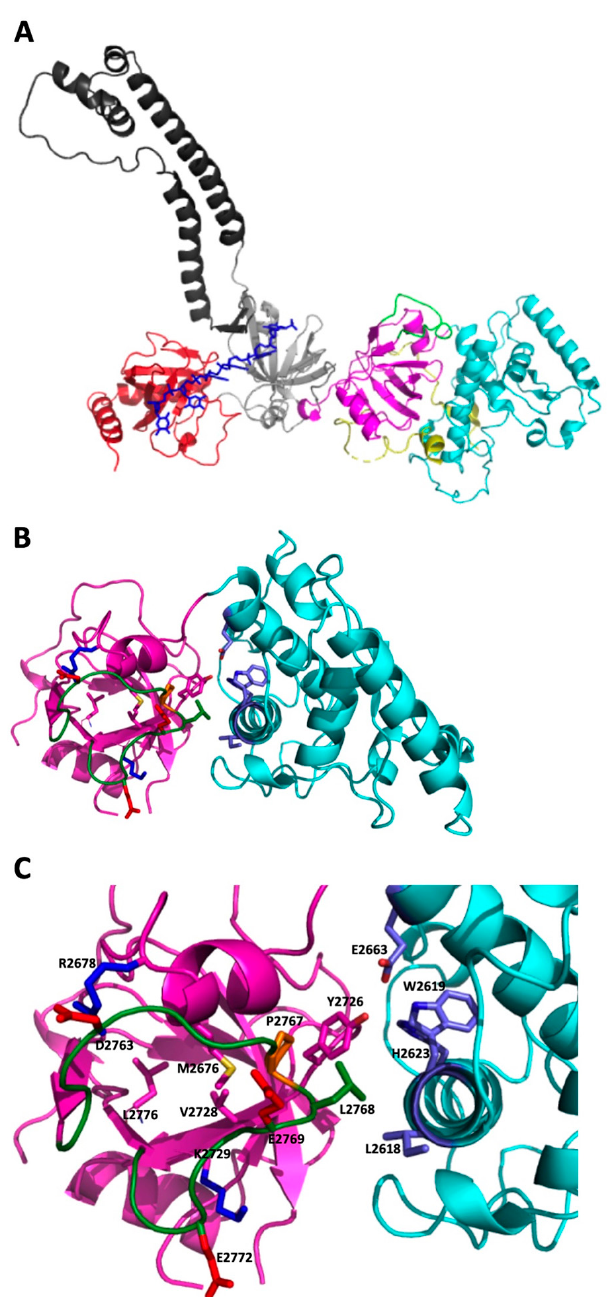
Figure 2. The 3D modeling analysis of the BRCA2 DBD. ( A ) A schematic representation of the structural model for the human BRCA2 DBD domain. N-terminal Helical domain (cyan); OB1 domain (magenta; L45 loop in green; the coiled-coil region L12 between β 1 and β 2 has been omitted from the model); OB2 domain (grey with the tower-like structure in dark grey); OB3 (red); ssDNA 6 nucleotides (blue); DSS1 protein fragment (yellow). The positions of ssDNA and DSS1 are derived from the 1MJE and 1MIU PDB structures. ( B ) A schematic representation of the H (cyan) and OB1 (magenta) domains. The loop L45 is shown in green. In stick representation, ( C ) the side chains of the following residues are represented: in the L45 loop, p.Pro2767 is depicted in orange, p.L2768 in green and the three acidic residues in red (p.D2763, p.E2769, and p.E2772). In the OB1 domain, p.Y2726, p.V2728, p.M2676 and p.L2776 are in magenta, whereas the basic residues p.R2678 and p.K2729 are shown in blue. In the H domain, p.E2663, p.W2619, p.H2623, and p.L2618 are shown in light blue. The secondary structure nomenclature refers to Yang et al.